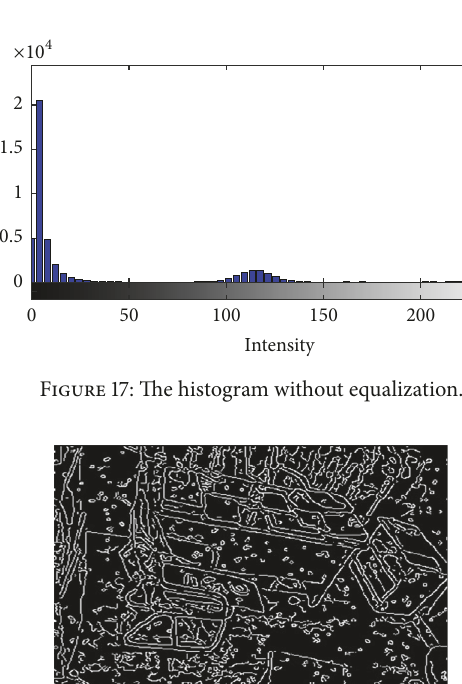
Figure 16: The tested image with noise.